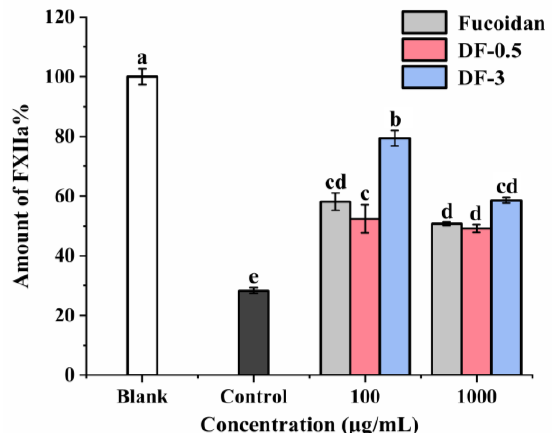
Figure 7. Effects of degraded fucoidans on the coagulation factor XII. Results were presented as mean ± SD (n = 2). The small letters (a-e) indicate the significant difference (p<0.05).